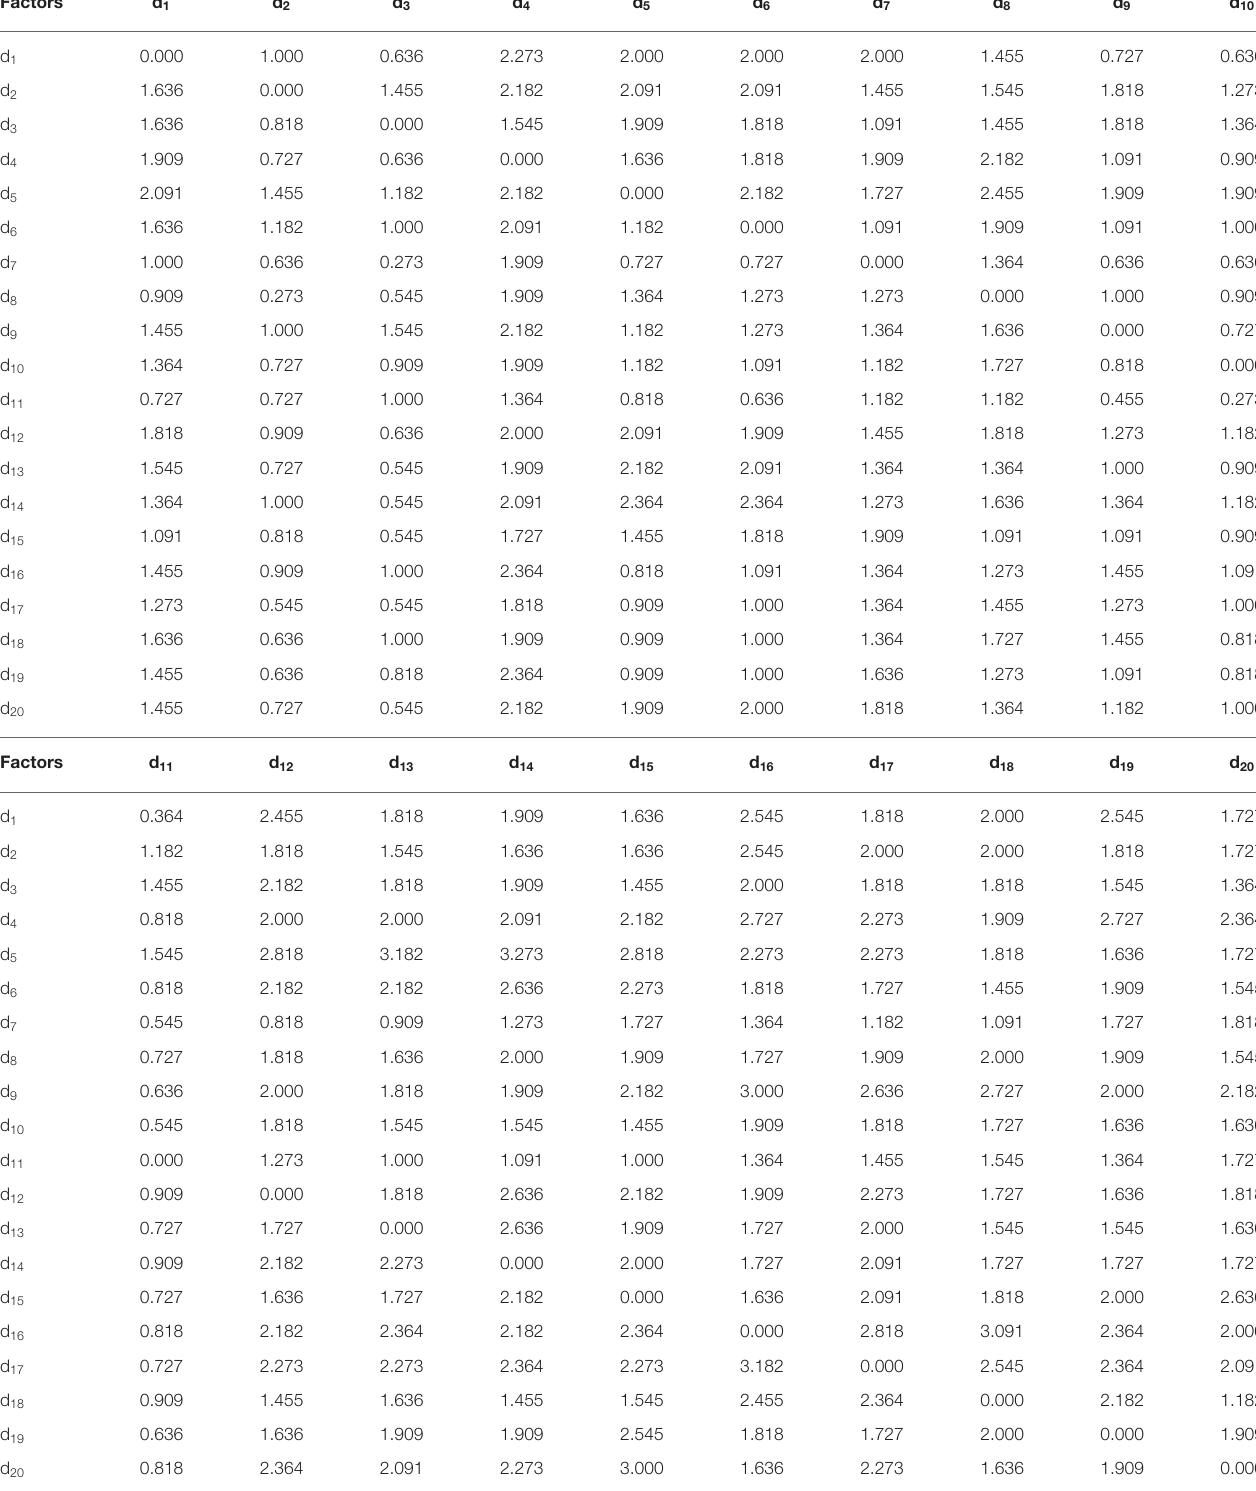
TABLE 3 | Initial direct relation matrix A between different influencing